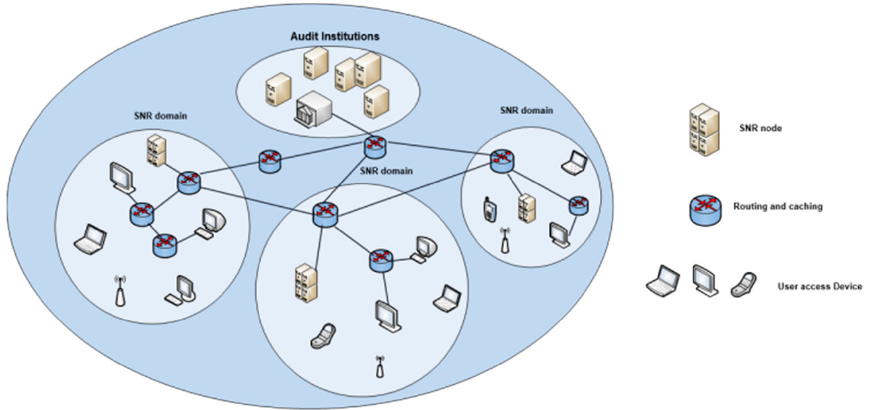
Figure 1. Relationship among user nodes, SNR nodes, and Audit Institutions.